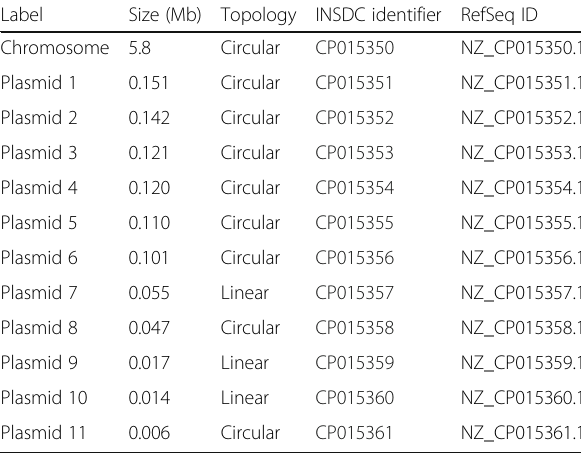
Table 3 Summary of genome: one chromosome and 11 plasmids Label